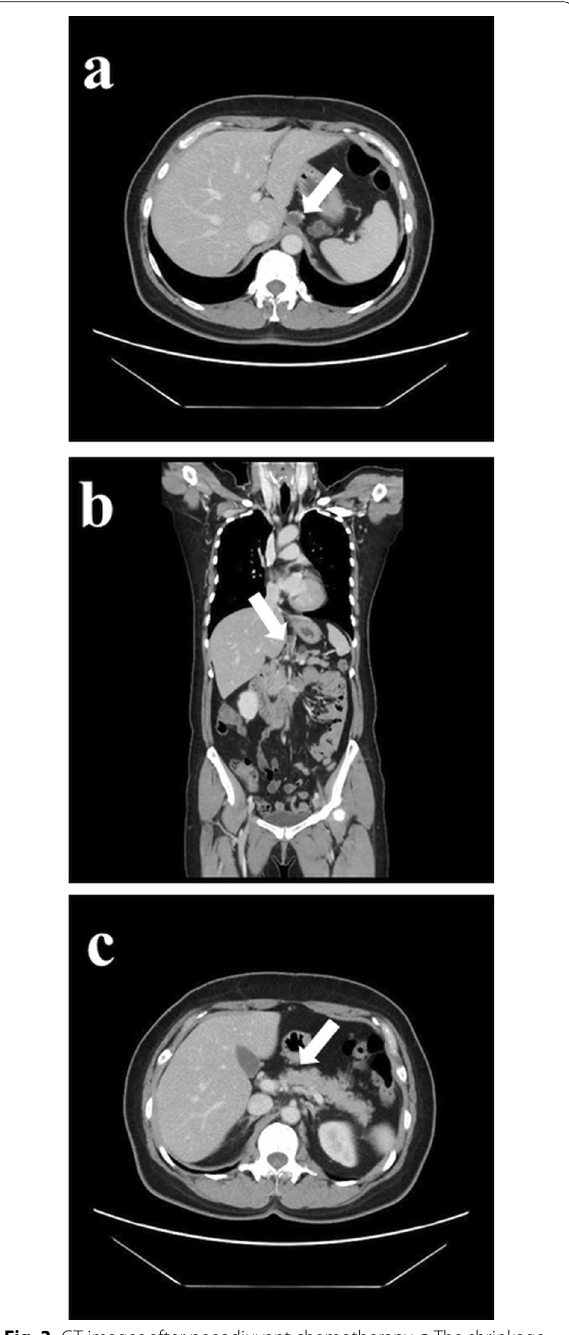
Fig. 3 CT images after neoadjuvant chemotherapy. a The shrinkage of both GDC and cystic formation of the pancreatic duct was observed (white arrow). b The fistula between the GDC and the pancreas could be observed (white arrow). c The tumor became unclear after neoadjuvant chemotherapy (white